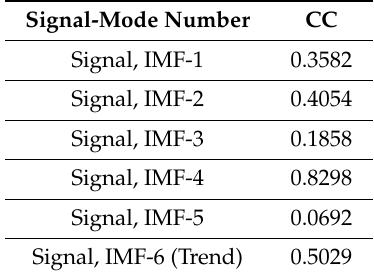
Figure 3. The EMD analysis of the TCPI signal in the North Indian Ocean. TCPI used here is derived using Dataset-2. The derived signal is shown in the first panel and its increasing trend in the seventh panel. Table 2. Correlation Coefficient (CC) values of the TCPI modes and the signal derived from Dataset-2. Signal-Mode